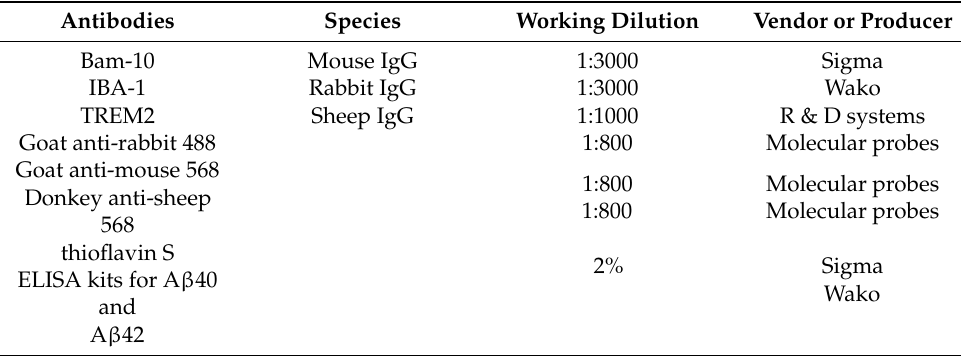
Table 1. Antibodies and ELISA kits used in the